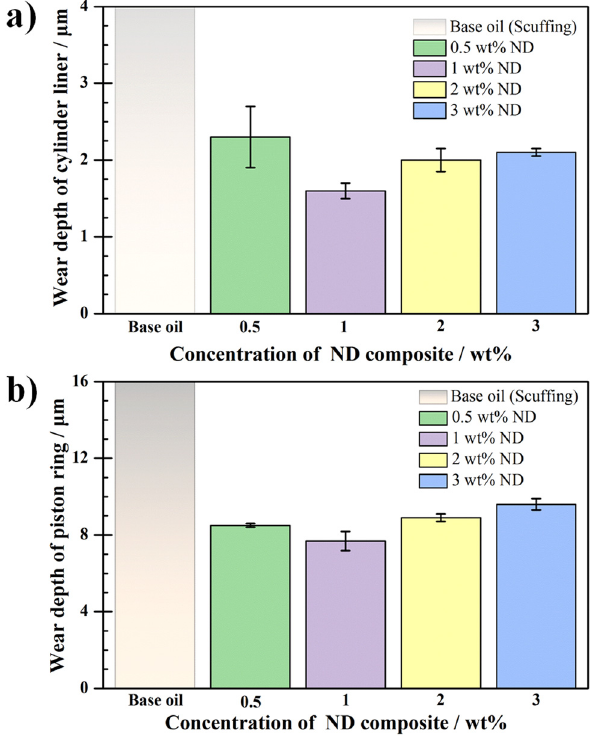
Figure 6: The wear loss of the friction pair: ( a ) wear depth of the cylinder specimen and ( b ) weight loss of the liner